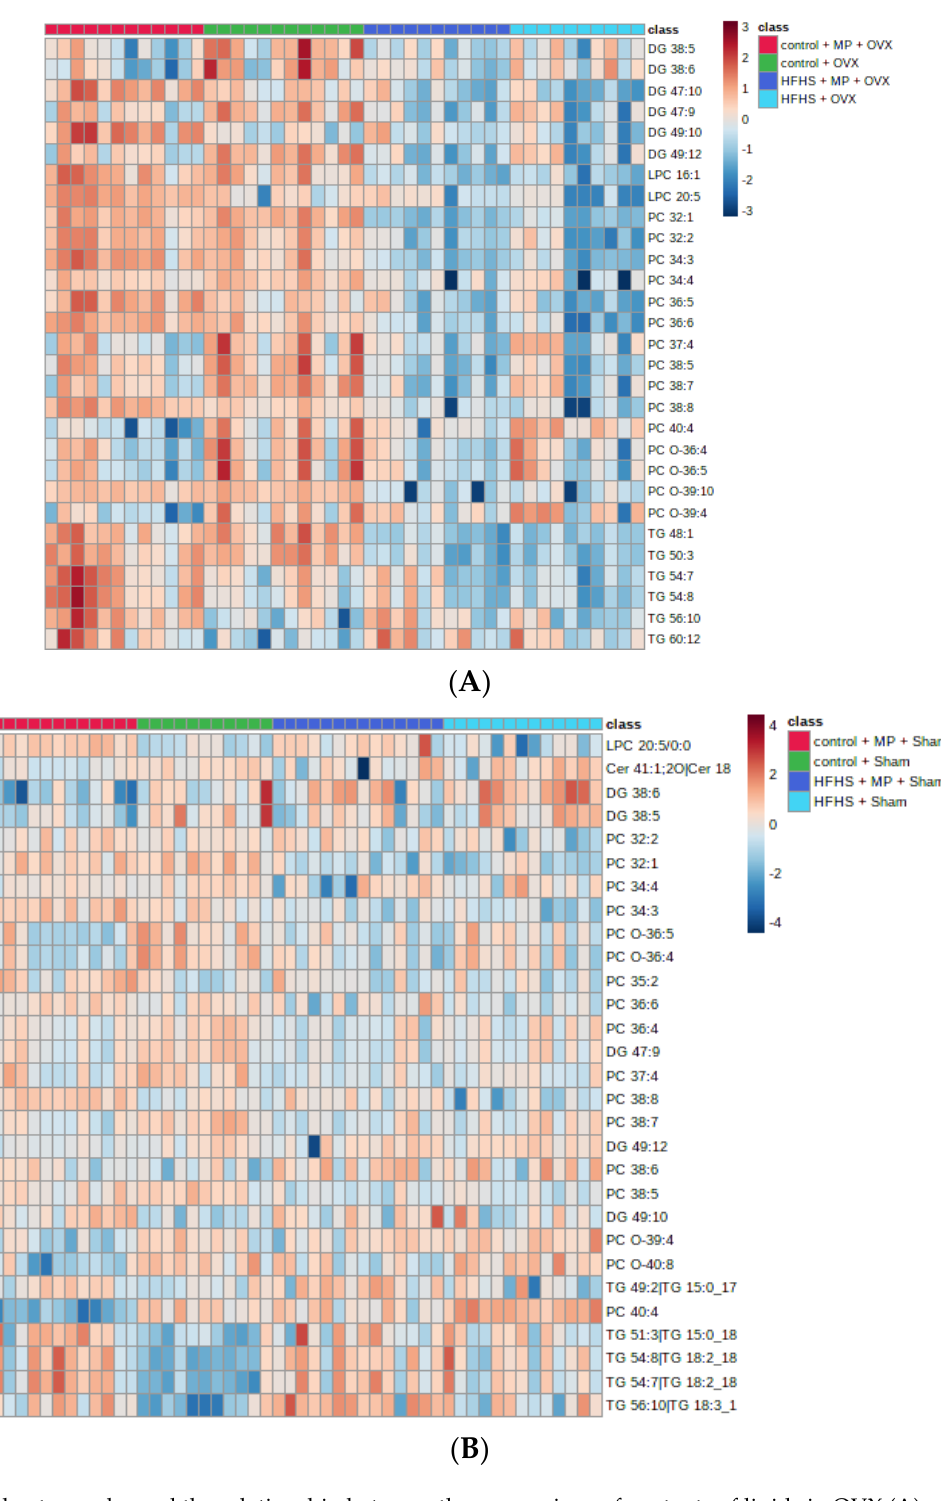
Figure 3. The heatmap showed the relationship between the comparison of contents of lipids in OVX ( A ) and sham ( B ); MP = greenshell mussel powder included in the diet. Each colour block corresponds to the value of relative content of each